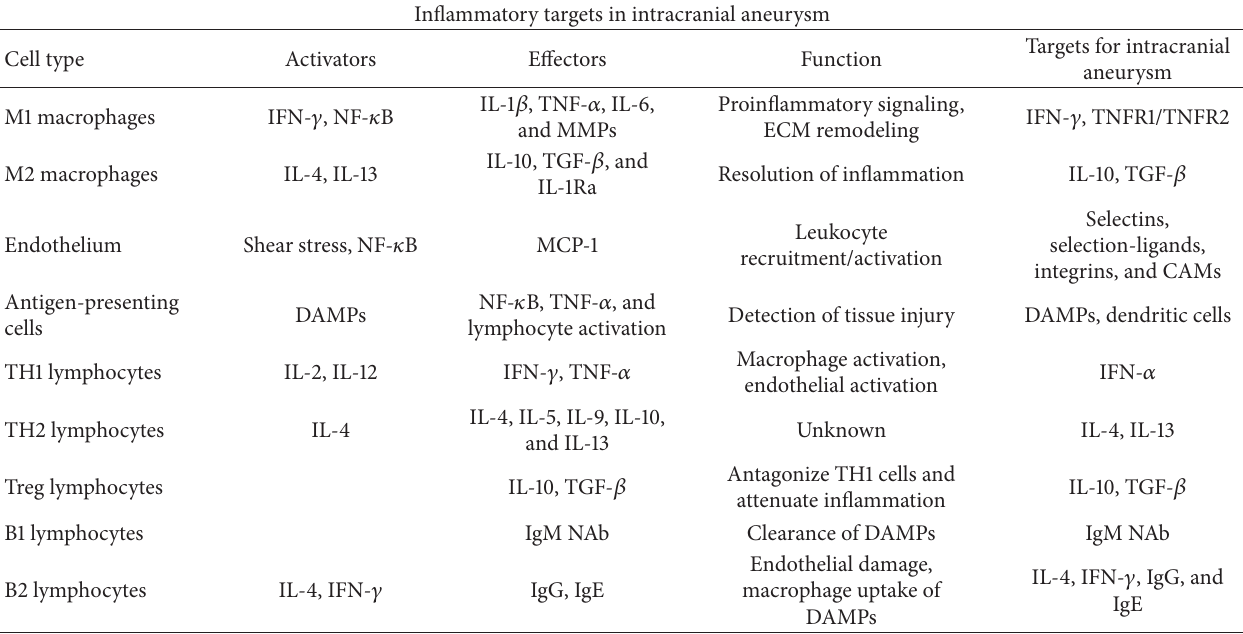
Table 1: A summary of some known and hypothesized inflammatory mediators with roles in intracranial aneurysm. This table provides an outline of possible avenues of investigation for further research into the immunopathology of